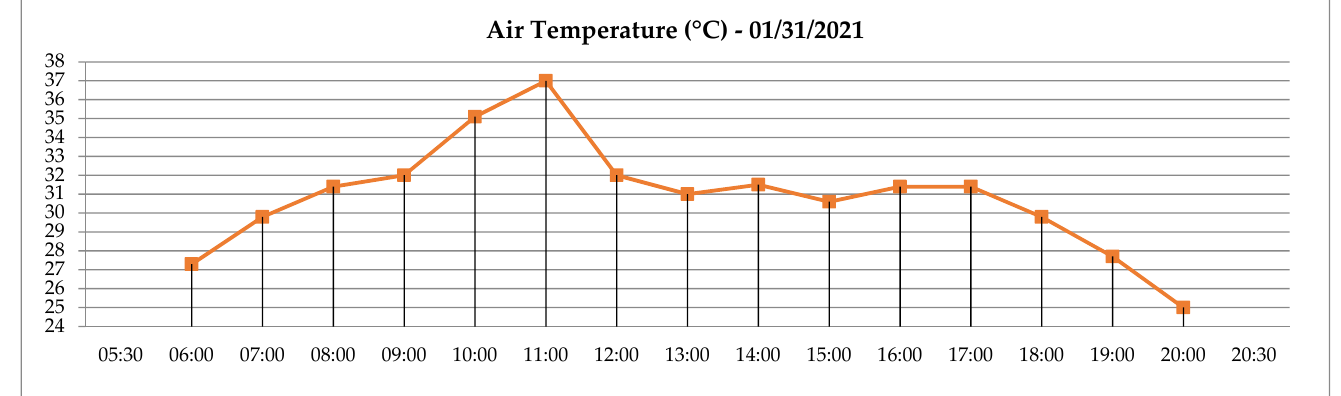
Figure 5. Rio de Janeiro—instantaneous temperature of the weather station at 01/31/2021.